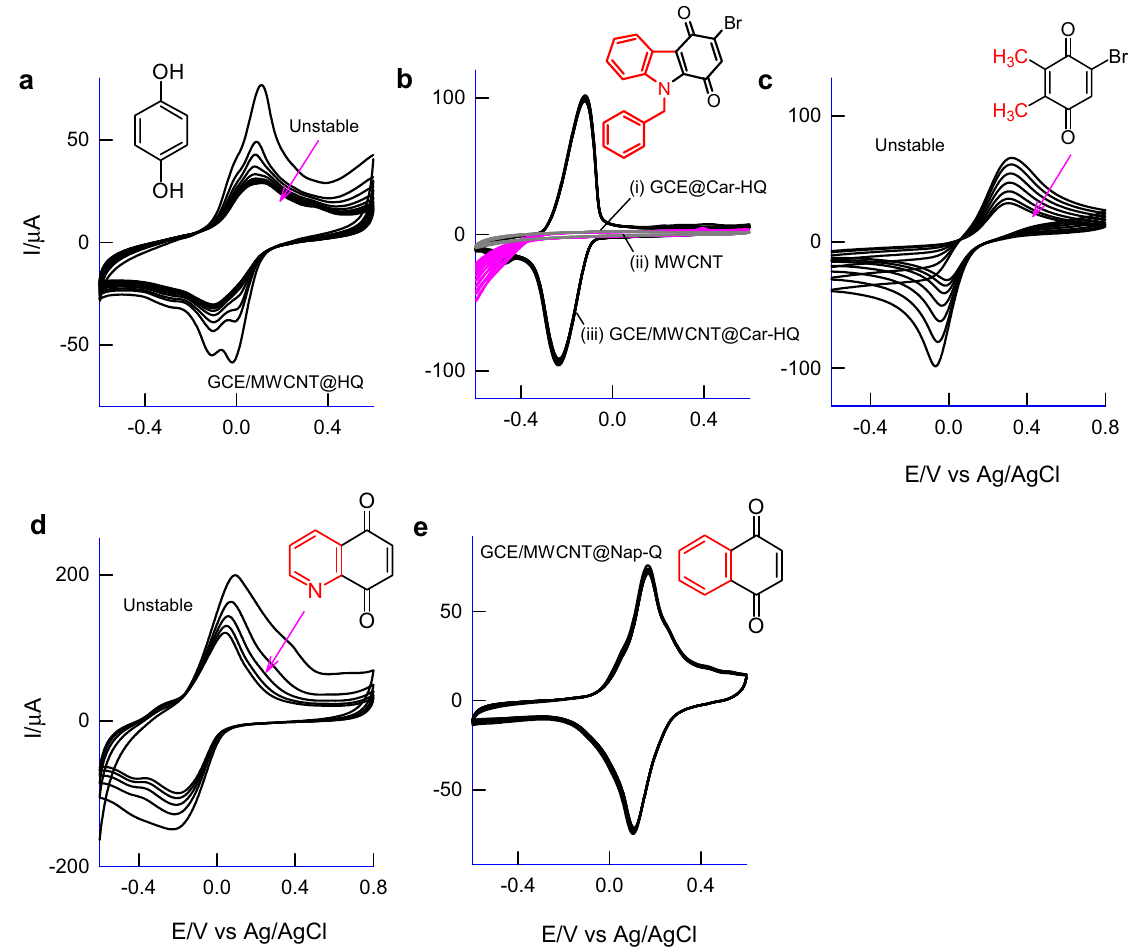
Figure 3. Ten continuous CV responses of various quinone-based redox-active organic compounds immobilized MWCNT modified glassy carbon electrodes ( a – e ) in pH 7 phosphate buffer solution at v = 50 mV s −1 . Insets figures are respective redox-active organic compounds used for